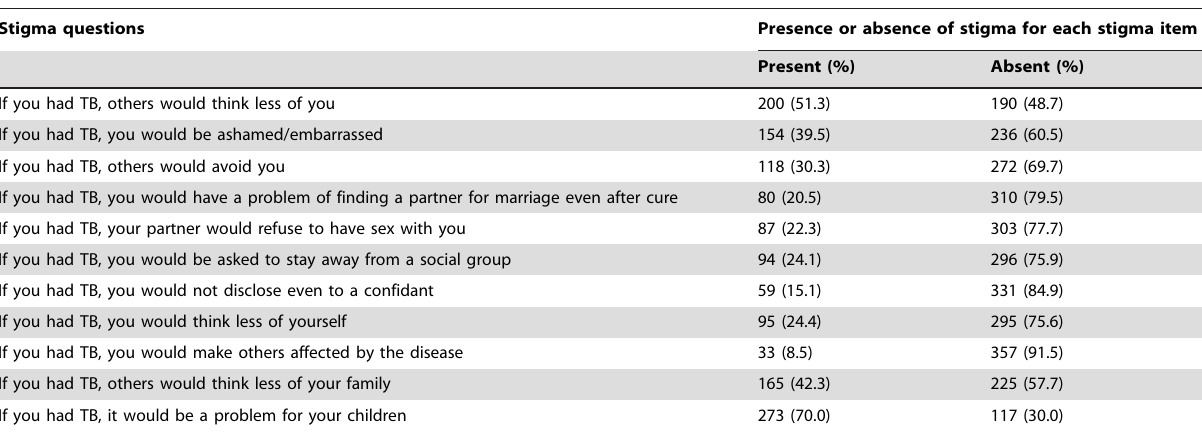
Table 4. Attitude of TB suspects (n=390) towards TB in the Gilgel Gibe field research area, southwest Ethiopia, March 2009.